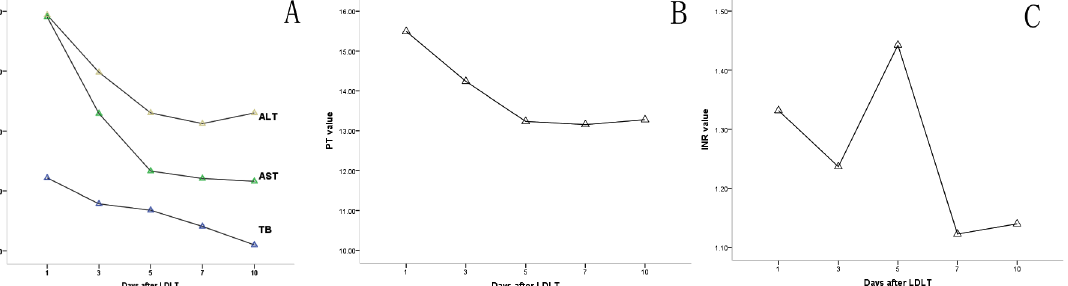
Fig 1. Post-operative biochemical parameter values in living donors after procedure. A: TB value returned to normal within the first week after procedure, but AST and ALT recovered after 7 days. B: PT value peaked on POD 1 and returned to normal within the first week. C: INR descended on the first 3 days after LDLT, but markedly increased and peaked at 4 th and 5 th